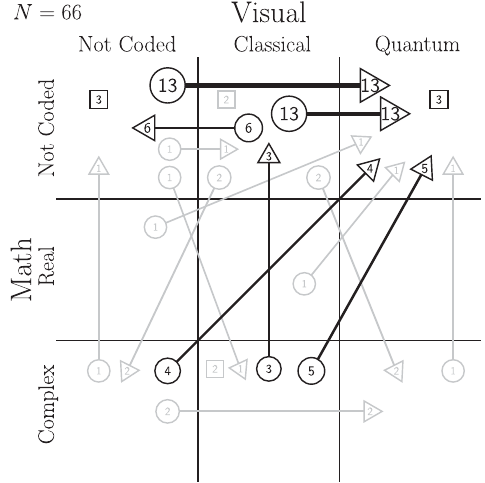
FIG. 5. Response transitions from pre- and midtest question 1a. Circles are pretest codes and triangles are the midtest codes for mathematical and visual. Note that the data presented are for the type of reasoning used, not correctness. Response patterns with less than three students are in gray to help illustrate overall trends.